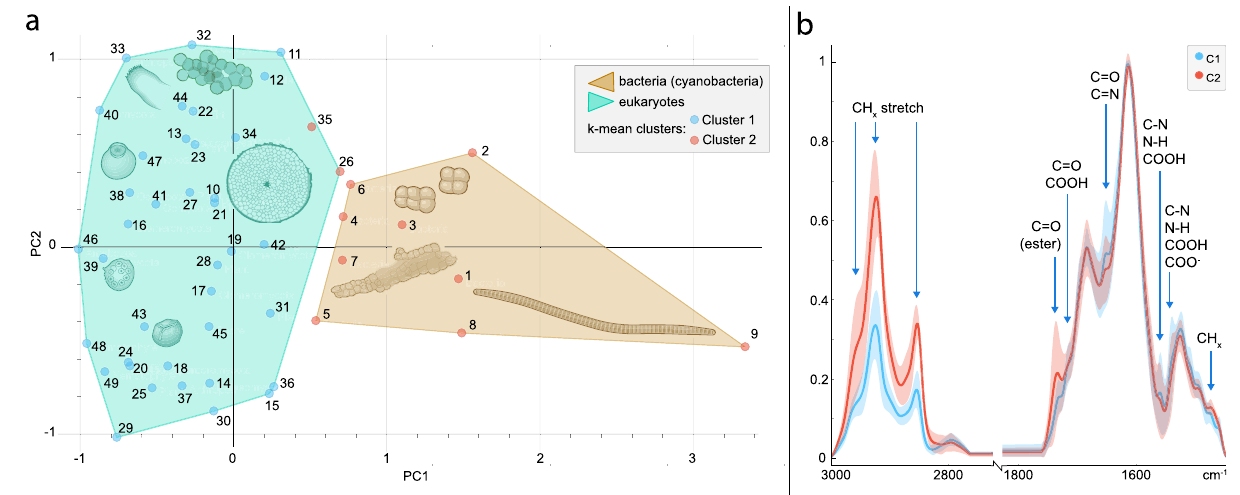
Fig.2|UnsupervisedanalysisofRhyniechertfossils.a K-meansclustering(blue/ red dots) and score plot for Principal Component Analysis (PCA) separating eukaryotes from prokaryotes on PC1 (convex hulls). Numbers correspond to the specimen numbers in Supplementary Data1. The cartoons represent an arthropod fragment, a plant spore, a plant axis, Palaeoleptochlamys hassii (putative arcellinid amoeba), Frankbaronia polyspora (putative peronosporomycete), and three cya- nobacteria: Palaeolyngbya kerpii , Rhyniosarcina devonica , and an unidenti fi ed Sti- gonema -liketaxon.CartoonsweredrawnfromRhyniechertorganismphotographs